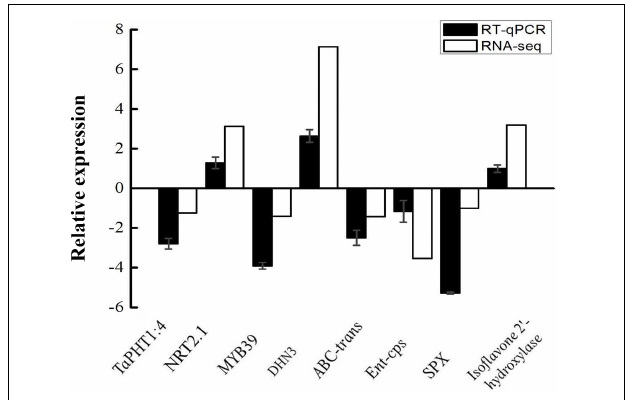
FIGURE 5 | Validation of RNA-seq expression profiles via